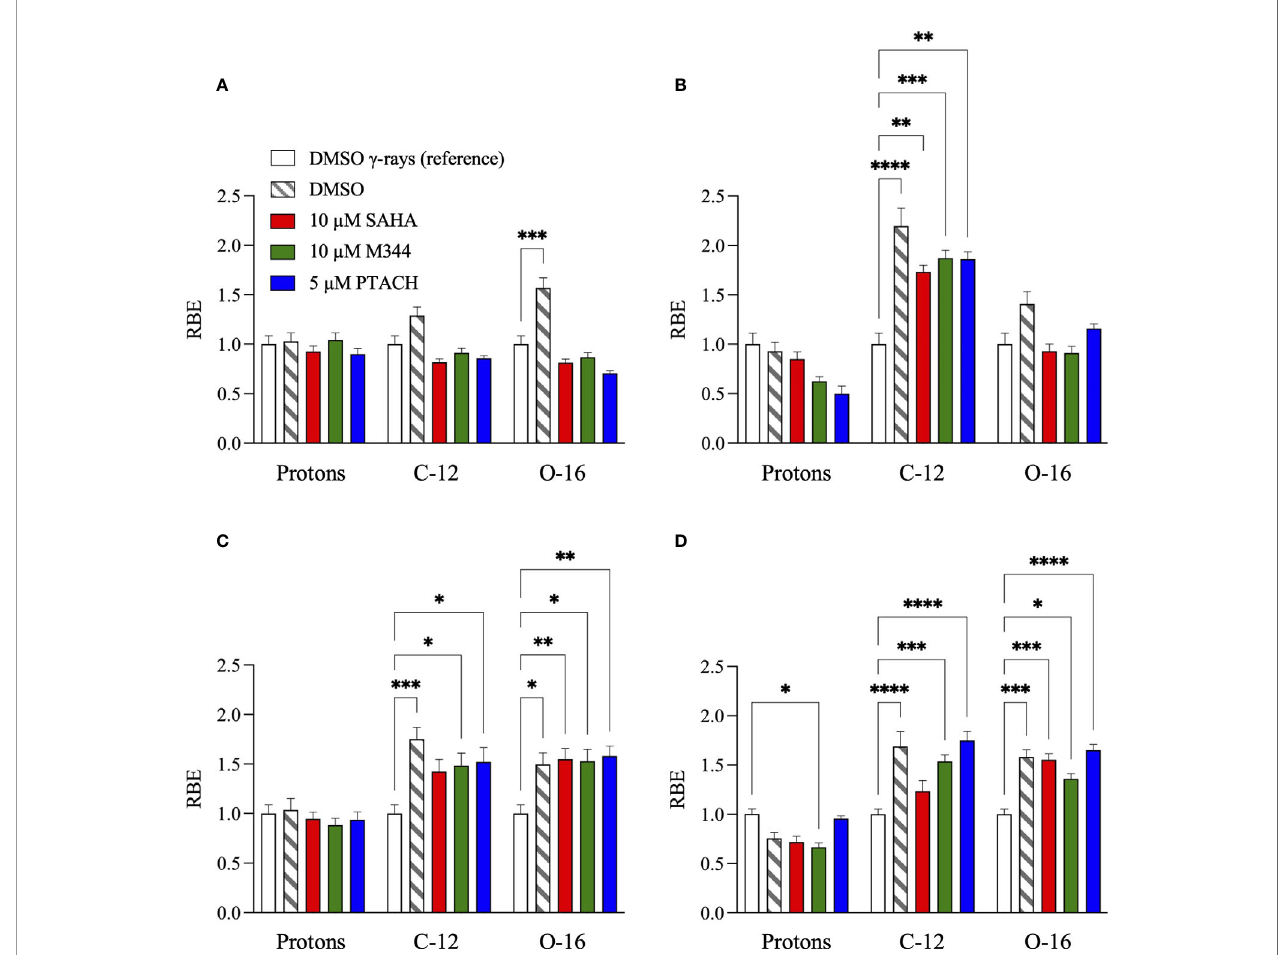
FIGURE 7 | Relative biological effectiveness (RBE) values ± SEM for G0/G1-phase normal NFF28 primary fi broblasts (A) and asynchronously growing A549 lung carcinoma (B) , U2OS osteosarcoma (C) , and U87MG malignant glioma cells (D) pretreated for 18 h with 10 µM SAHA, 10 µM M344, and 5 µM PTACH and irradiated 200 MeV protons, 290 MeV/n C-12 ions, or 350 MeV/n O-16 ions compared to respective DMSO control or HDACi-pretreated cultures exposed to reference cesium-137 g -rays [calculated using D 10 survival values; asterisks mark signi fi cant differences at p -values of ≤ 0.05 (*), ≤ 0.01 (**), ≤ 0.001 (***), and ≤ 10 − 4 (****) by two-way